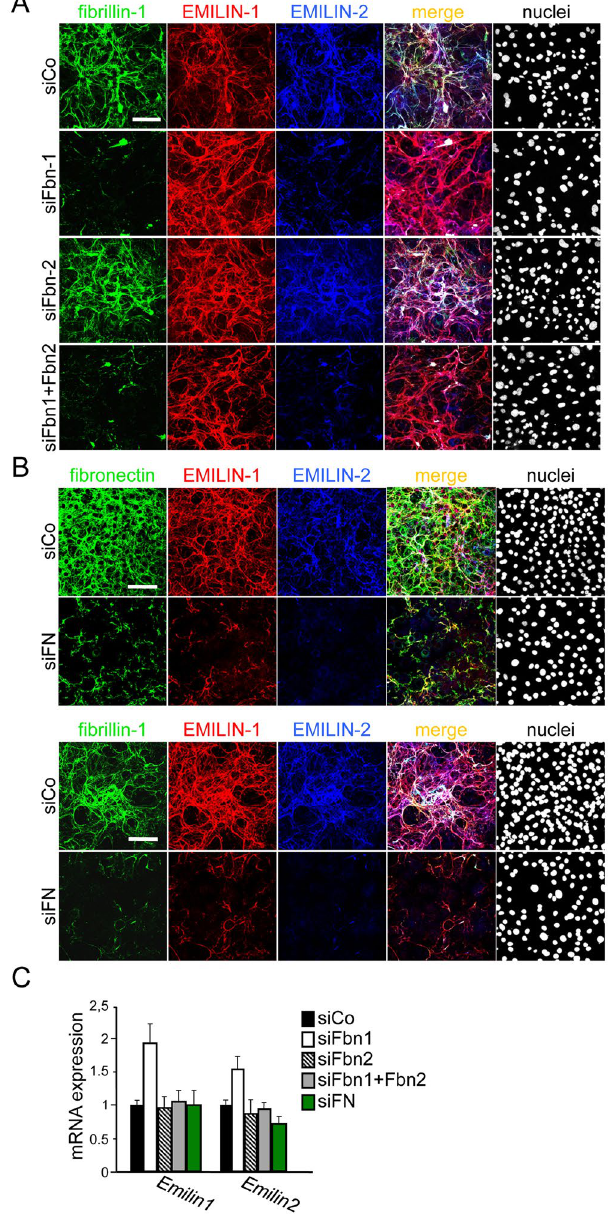
Figure 2. Specific role of fibrillins and fibronectin for EMILIN-1 and EMILIN-2 incorporation in the ECM produced by primary calvarial osteoblasts. ( A ) Confocal immunofluorescence microscopy analysis of in vitro matrix fiber formation. Primary calvarial osteoblasts derived from wild type newborn mice were reverse transfected with the indicated fibrillin siRNAs, grown for four days and probed by immunostaining with the indicated antibodies. Knockdown of fibrillin-1 alone was sufficient to impair EMILIN-2 incorporation in the ECM, while even the double knockdown of fibrillin-1 and fibrillin-2 was ineffective in preventing EMILIN-1 matrix deposition. For the double knockdown of fibrillins, a single siRNA for each gene was used. ( B ) siRNA mediated knockdown of fibronectin in primary calvarial osteoblasts was sufficient to completely prevent EMILIN-1 and EMILIN-2, as well as fibrillin-1 fiber formation. ( C ) qPCR analysis on transfected cells revealed that mRNA levels were mostly not affected by siRNA treatment, apart from a slight increase in Emilin1 and Emilin2 expression after fibrillin-1 knockdown. All siRNA knock-down experiments were performed three times (n = 3). Scale bars: 75 μ